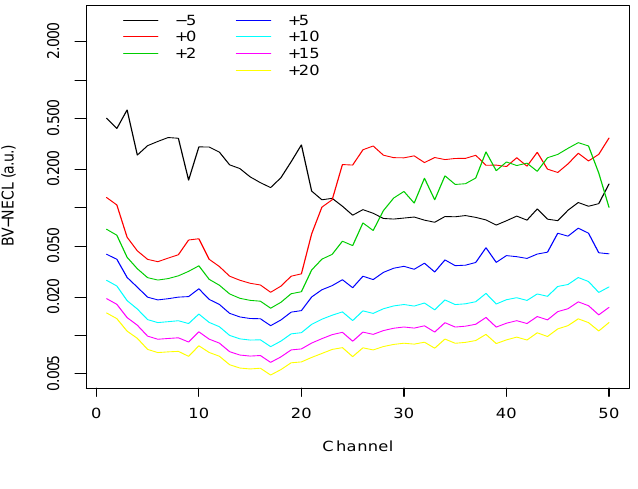
Figure 3. Segmented Basis Vector NECL Values: Group 1. NECL values for the 50 unit vectors (corresponding to the 50 spectral channels) were computed at 7 different plume temperatures from − 5 ◦ K to +20 ◦ K more than the average ground temperature 311 . 6 ◦ K. Only the pixels assigned to Group 1 were used in the